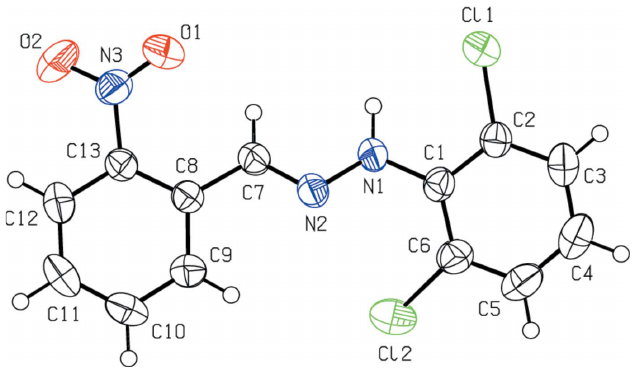
Figure 1 The molecular structure of the title compound, showing the atom labelling and displacement ellipsoids drawn at the 50% probability level.